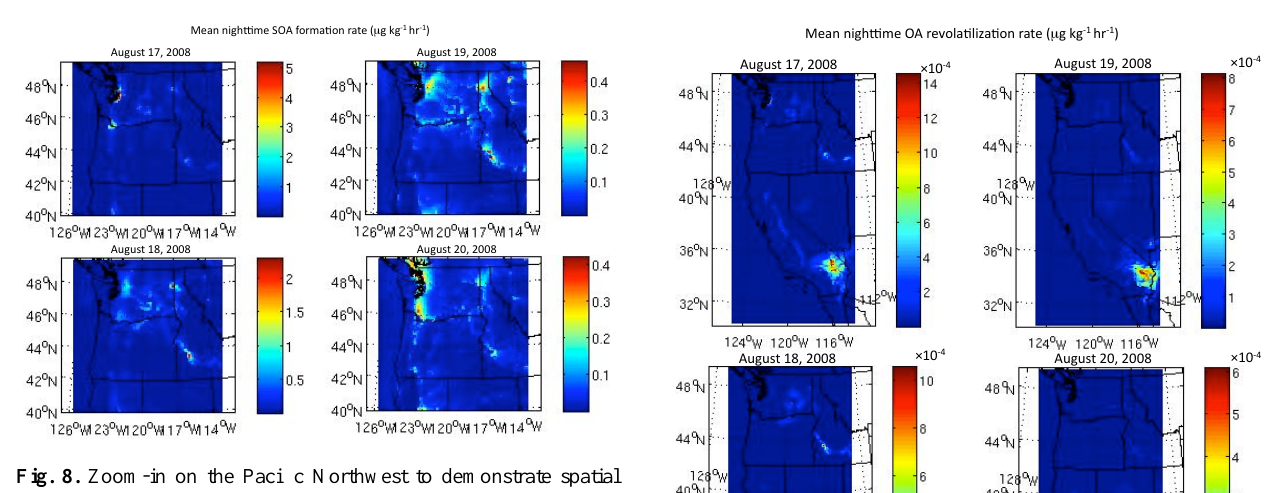
-initiated SOA source, showing spatial 3